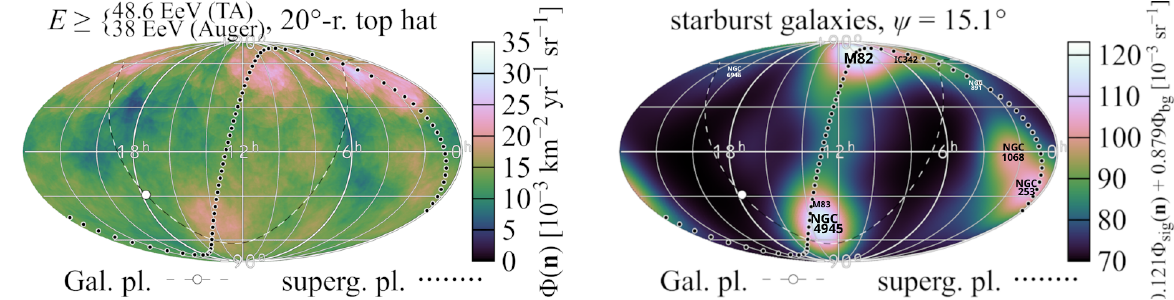
Figure 4. The observed UHECR flux above 38EeV on the Auger scale (49EeV on the TA scale) (left), compared to the starburst galaxy model predictions